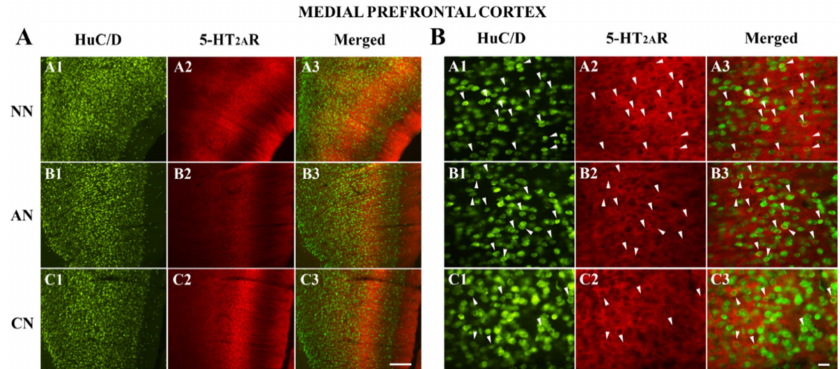
Figure 5. ( A ) Colocalization of the HuC / D with 5-HT 2A receptor (5-HT 2A R) in the medial prefrontal cortex (mPFC, layers V and VI) of naïve nicotine (NN) (A1–A3), acute nicotine (AN) (B1–B3) and chronic nicotine (CN) (C1–C3) rats. Double immunofluorescence images showing HuC / D in green (left column pictures; A1, B1, and C1), 5-HT 2A R in red (middle column pictures; A2, B2, and C2), and colocalization of HuC / D with 5-HT 2A R in yellow (right column merging pictures; A3, B3, and C3). Note the high 5-HT 2A R immunoreactivity in the mPFC of nicotine-naïve and chronic nicotine rats. See text and Table 2 for explanations. Scale bar = 200 µ m in C3 (applies to A1–C3). ( B ) Colocalization of the HuC / D with 5-HT 2A receptor (5-HT 2A R) in the mPFC (layers V and VI) of nicotine-naïve (A1–A3), acute nicotine (B1–B3), and chronic nicotine (C1–C3) rats. Double immunofluorescence images showing HuC / D in green (left column pictures; A1, B1, and C1), 5-HT 2A R in red (middle column pictures; A2, B2, and C2), and colocalization of HuC / D with 5-HT 2A R in yellow (right column merging pictures; A3, B3, and C3 arrowheads indicate double-labeled neurons). The proportion of 5-HT 2A R-immunoreactive neurons to the total neurons does not show significant di ff erences comparing the di ff erent groups. See text and Table 2 for explanations. Scale bar = 25 µ m in C3 (applies to A1–C3).